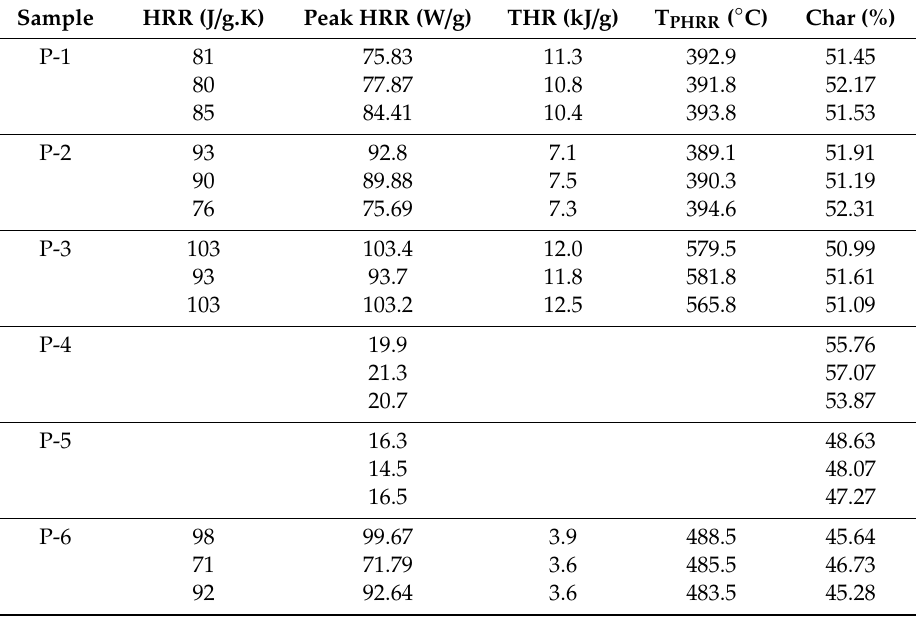
Figure 14. Heat release rate (HRR) of polymers P-1 to P-6 vs. time. Table 3. Microcalorimetry data of polymers P-1 to P-6.